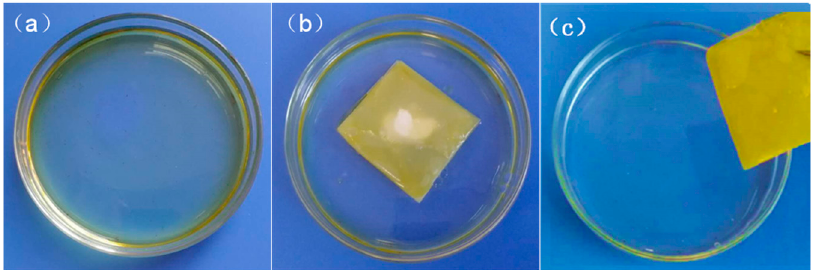
Figure 12. Oil absorption process of PLLA nanofiber membrane with acetone treatment: ( a ) before oil absorption; ( b ) floating on the water; ( c ) after oil absorption.